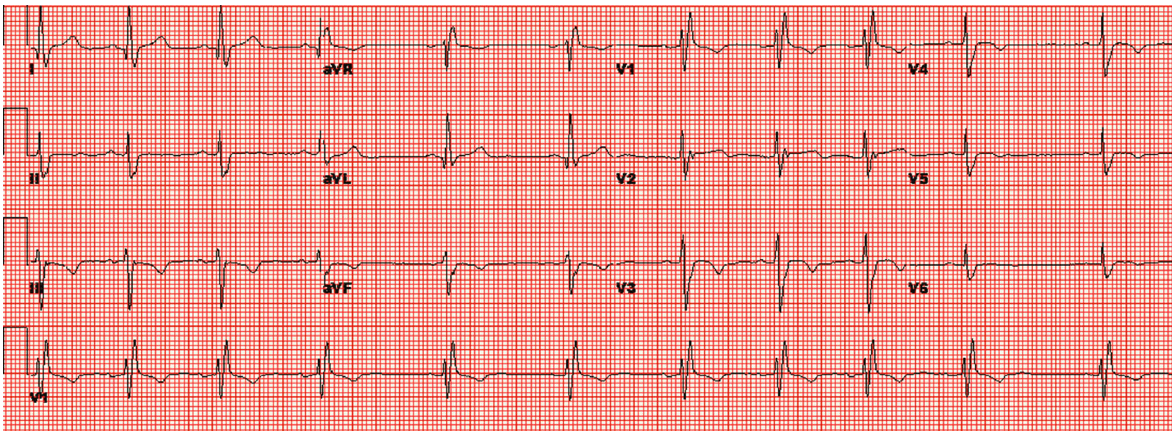
Figure 2: Electrocardiogram showing normal sinus rhythm with right bundle branch block, left anterior fascicular block, and secondary T wave